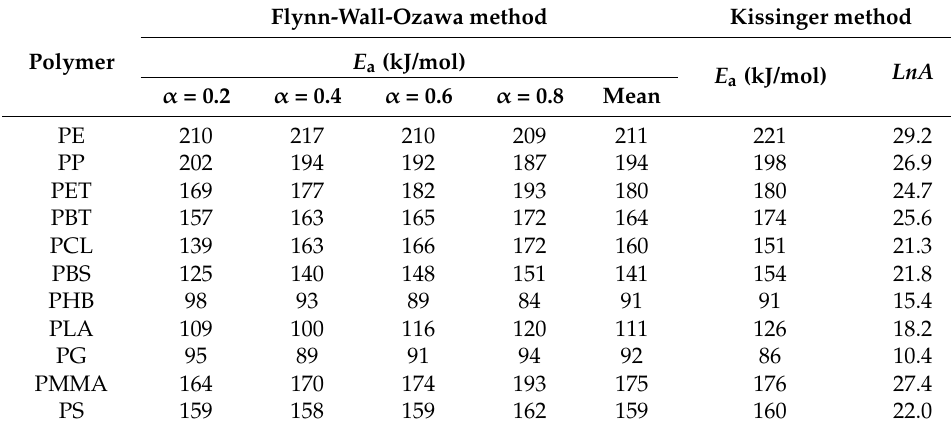
Table 2. Kinetic parameters measured for all studied polymers.